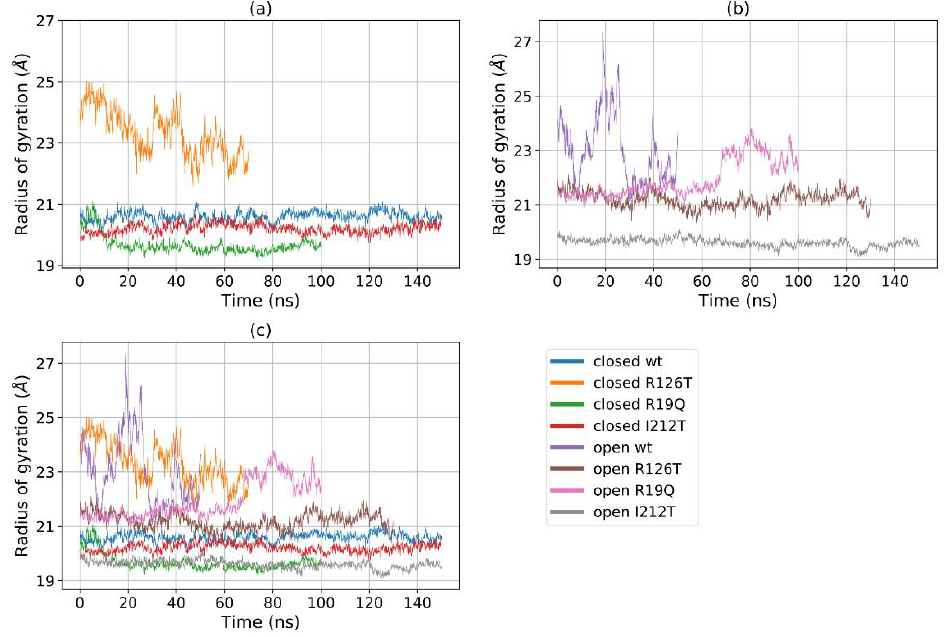
Figure 5. R g of ( a ) all the eight investigated systems, ( b ) all the closed systems, ( c ) all the open sys- tems.